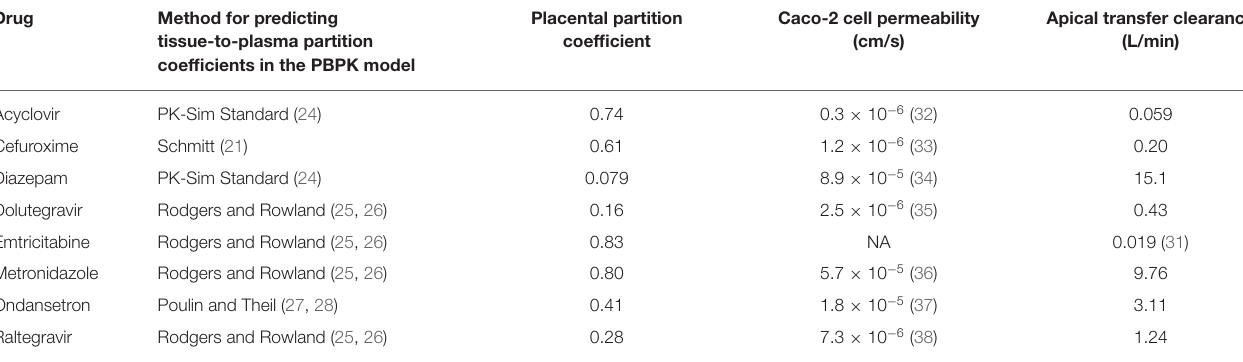
TABLE 2 | Overview of the methods for predicting the tissue-to-plasma partition coefficients of each drug in the PBPK model and placental transfer model parameters. Drug Method for predicting tissue-to-plasma